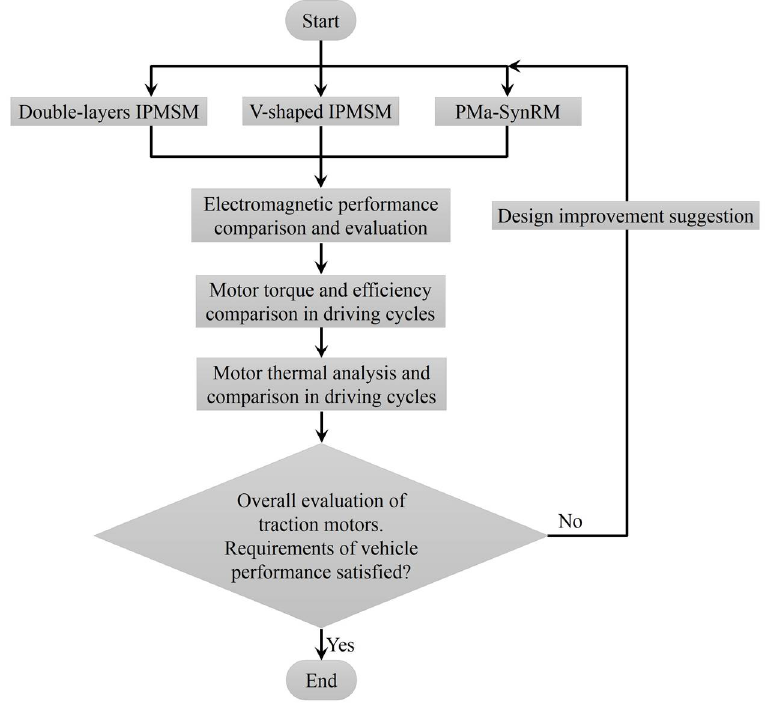
Figure 3. The analysis process for traction motors with driving cycle.